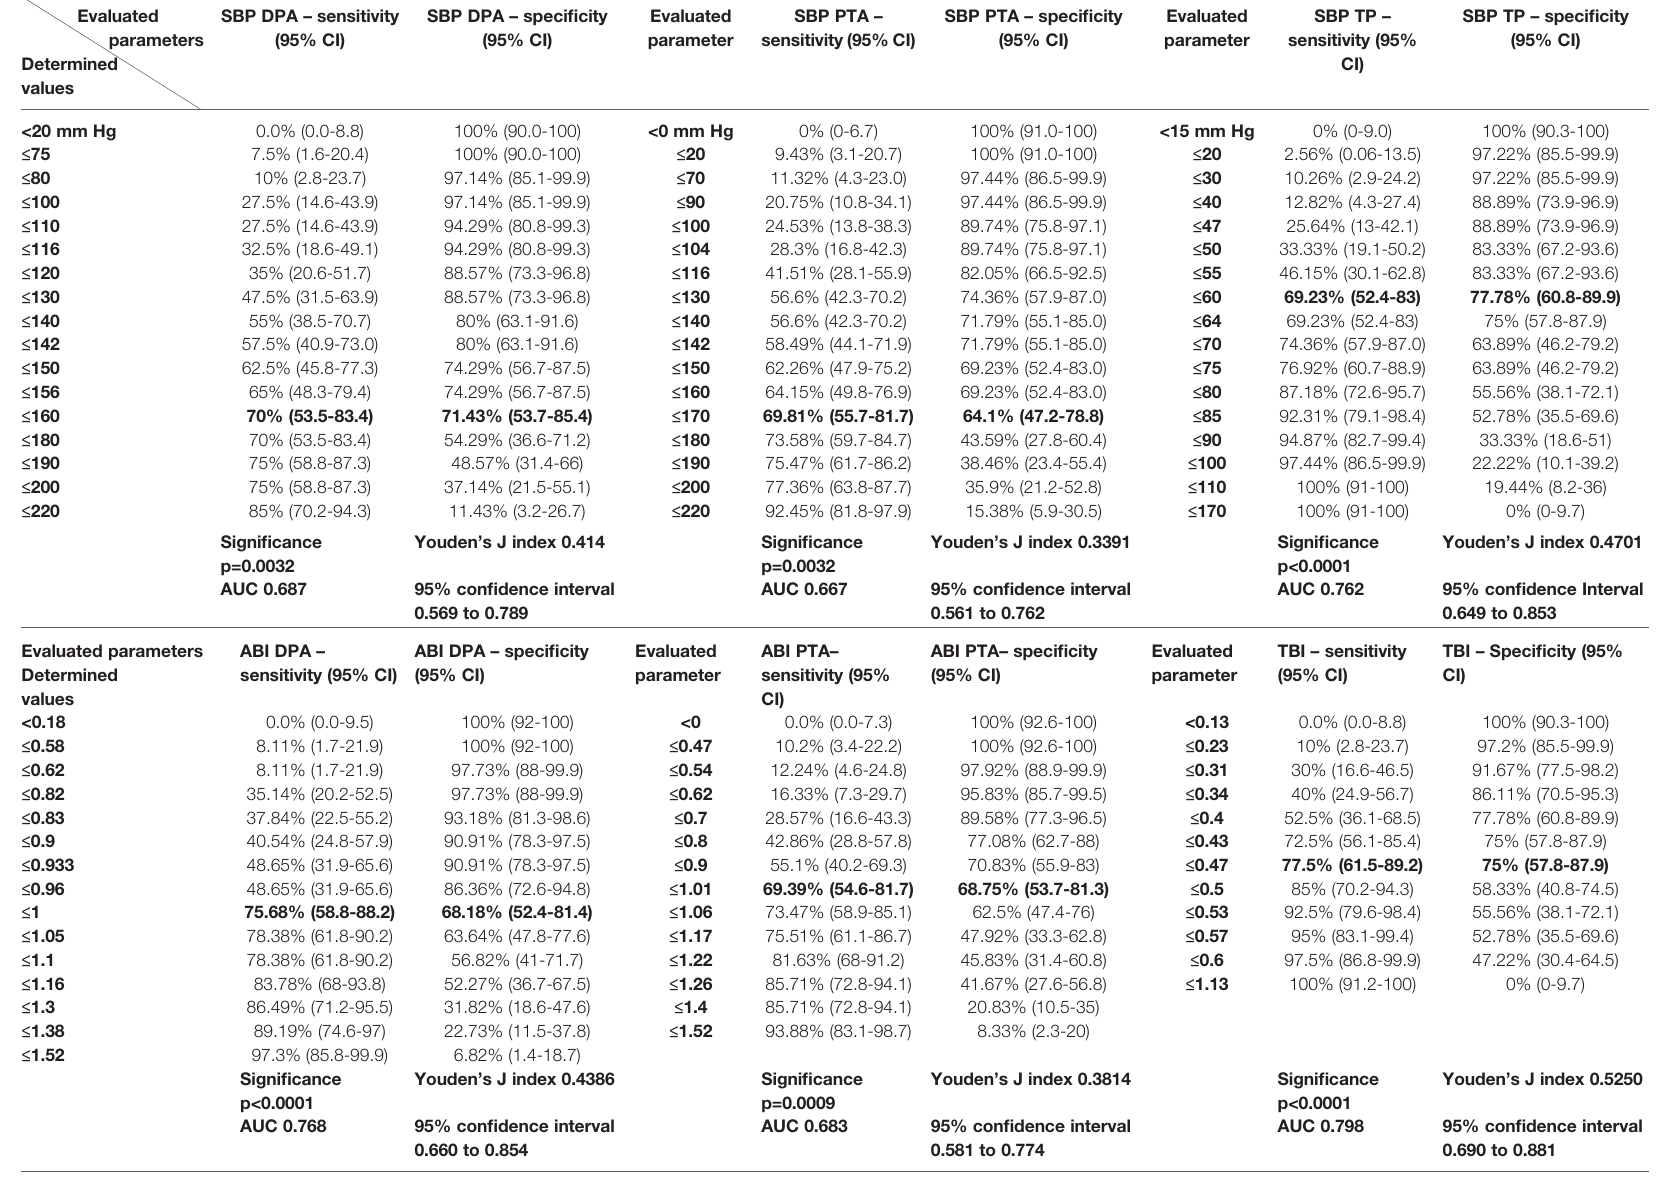
TABLE 4 | Sensitivity and speci fi city of individual macrovascular assessment in relation to monophasic arterial fl ow supplying the relevant angiosome. Evaluated parameters Determined